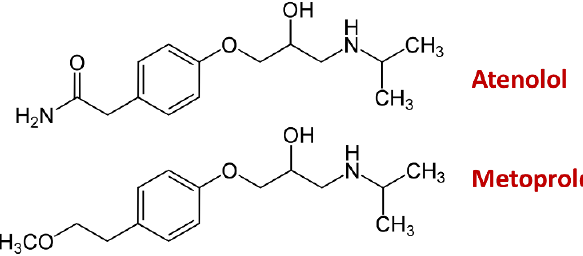
Figure 1. Atenolol shares metoprolol chemical moiety.